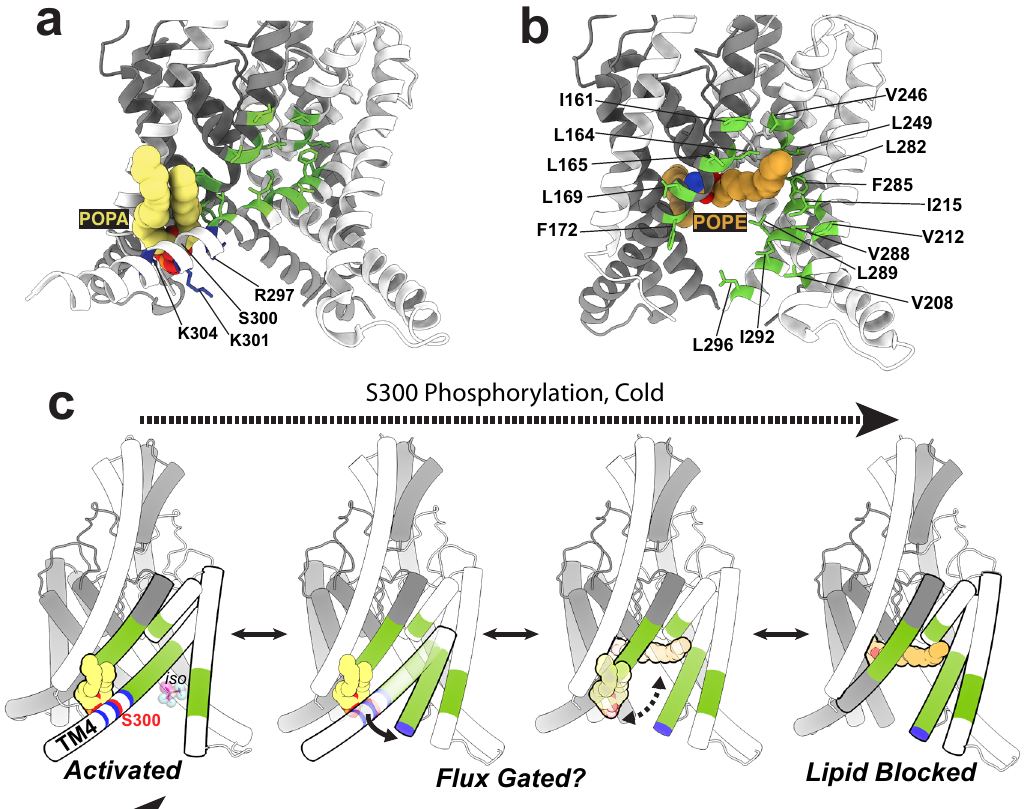
Fig. 6 | An integrated model of TREK1 lower pore gating. Comparison of the POPA and POPE bound TREK1 structures. In the POPA structure ( a ), the lipid pathway is closed, with no lipid occluding the ion-conducting pore and positively charged residues (blue) in the distal end of TM4 enveloping the anionic POPA headgroup. Inthe POPE structure( b ),hydrophobic residues (green) on TM2, TM3,